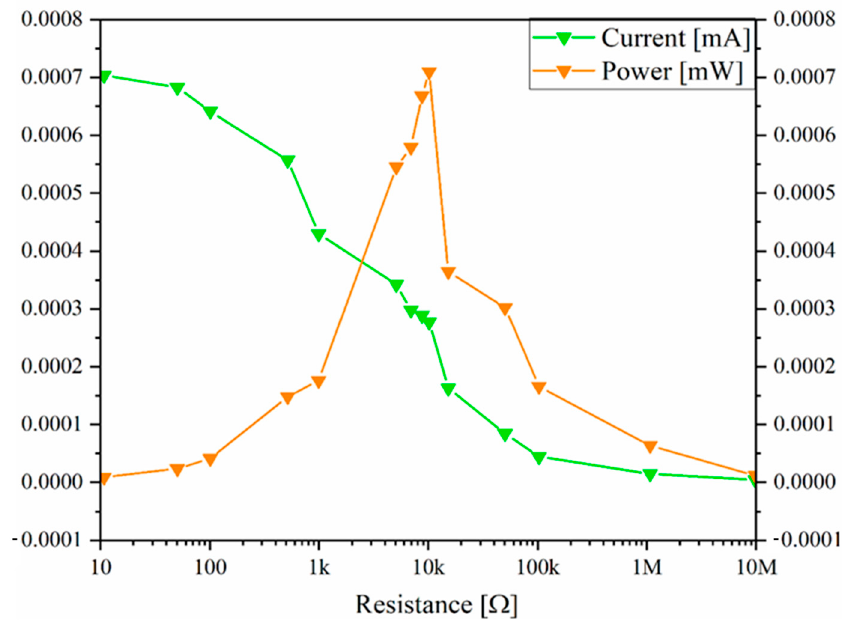
Figure 12. Electrical power output measured with different load resistances with a rotational speed of 250 rpm and a temperature difference of 45 °C .